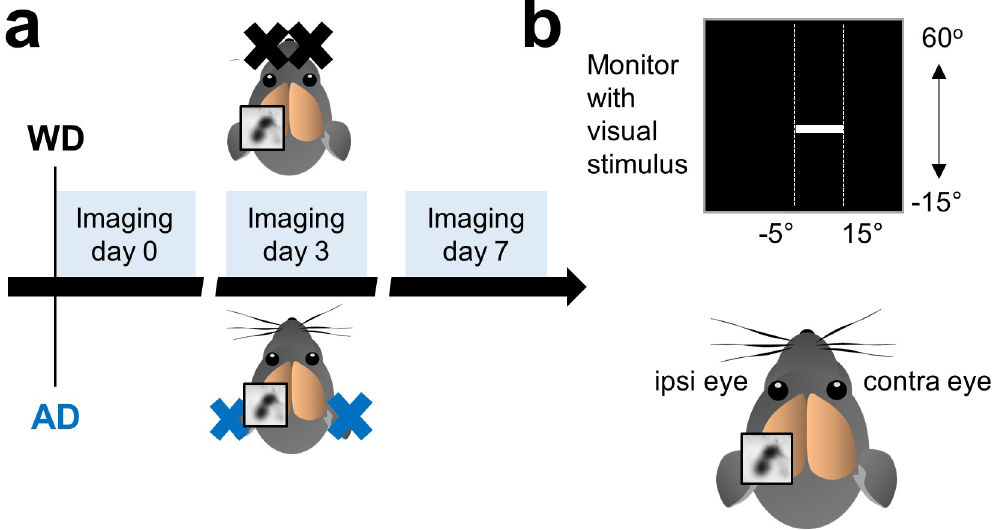
Fig 1. Experimental time course and schematic illustration of intrinsic signal imaging. ( a ) In one group of mice we performed WD by bilaterally plucking all macro-vibrissae and in another group we induced AD by bilateral malleus removal. The first imaging session (day 0) for mapping V1 started immediately after the deprivation followed by a second imaging session at day 3 and a third imaging session at day 7. ( b ) For visual stimulation we used an upward or downward moving white light bar with 100% contrast which was presented in the right binocular visual field. We always recorded V1 responses in the left hemisphere. Thus, according to the position of the recorded hemisphere the left eye represents the ipsilateral and the right eye represents the contralateral